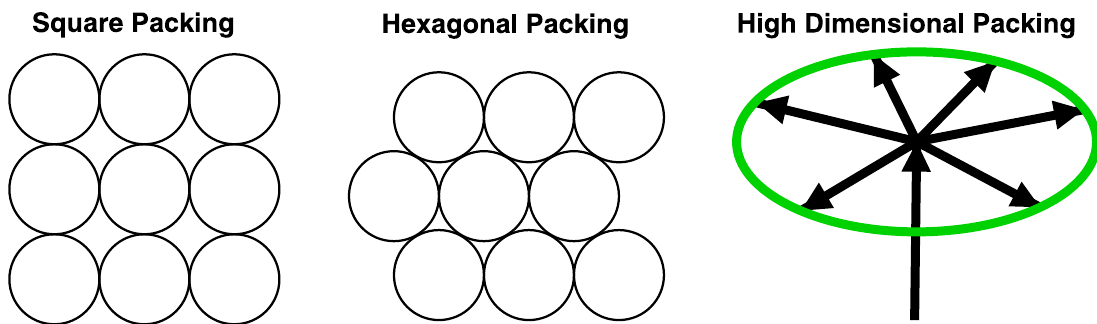
Fig 1. Sphere packing. Circles demonstrate square and hexagonal sphere packing in two dimensions. The hexagonal packing is 12% more dense. In higher dimensional spaces sphere packing is less intuitive. When hyperspheres pack together there is an odd property diagramed on the right side of the figure (which is derived from Shannon’s proof of the channel capacity theorem, Theorem 2 in his figure 5 [15]). The vertical arrow represents moving from the center of one hypersphere to the center of a second hypersphere. For Shannon, working with electrical communications, this voltage is proportional to the square root of the power dissipation, the thermal noise in the second sphere (green circle) disturbs the signal in all directions, shown by splayed arrows with lengths ffiffiffiffi p proportional to . However, 99 of those dimensions do not perturb in the direction of the power dissipation. In his proof, Shannon N neglected the 1% of the noise in the direction of the power since this represents the error, and it can be made as small as one may desire by increasing the dimensionality—in 1000 dimensions the error is only 0.1%. So relative to the direction of the power, the received hypersphere can be treated as a flat surface since all the other directions (splayed arrows) are at right angles to the power direction. If two hyperspheres are to be separated with as low an error as desired, then the power to get from one to the next must just exceed the thermal ffiffiffi p ffiffiffiffi p noise power of the first sphere, so > and P > N . P N